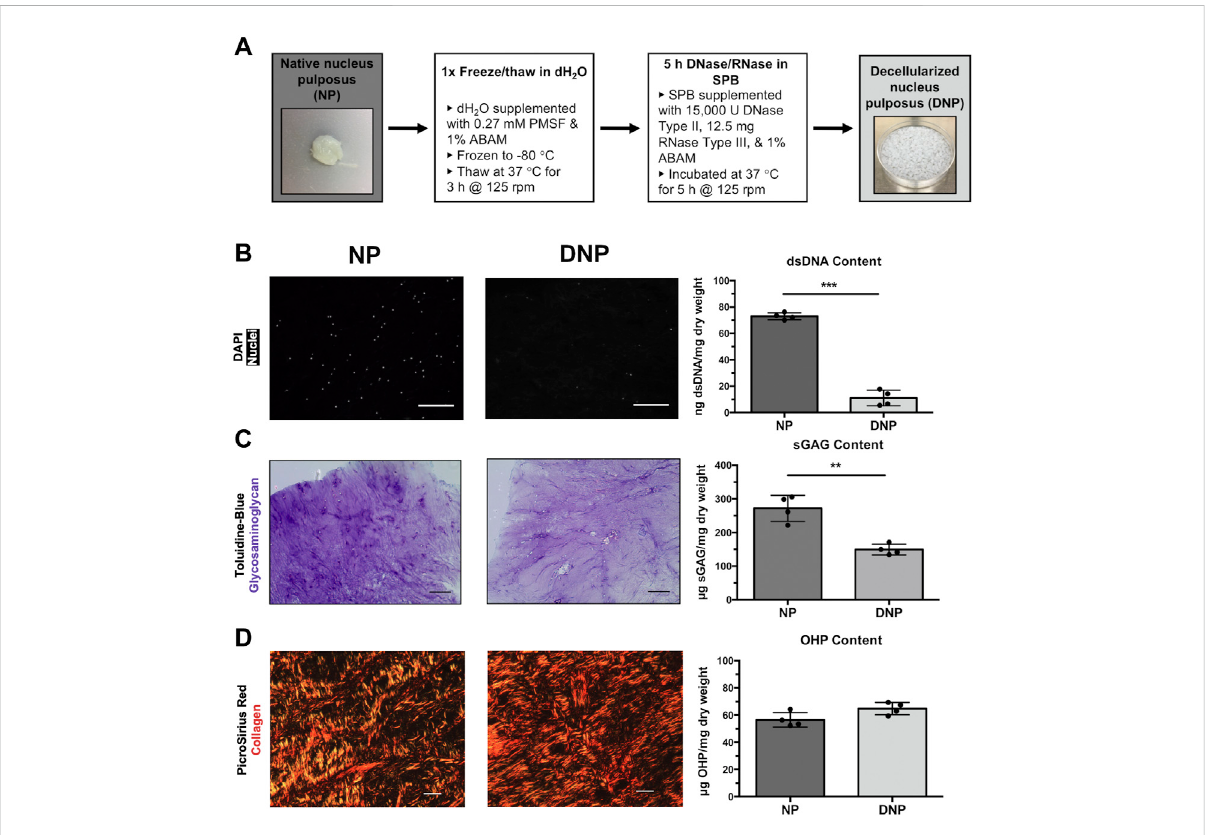
FIGURE 1 Detergent-free NP decellularization protocol effectively extracts cellular content while retaining sulphated glycosaminoglycan (sGAG) and collagen content from native NP. (A) Schematic of detergent-free decellularization protocol. (B) Representative DAPI stained sections of native nucleus pulposus tissue (NP) and decellularized NP (DNP) showed a reduction in cell nuclei (pseudo-coloured in white) following decellularization. Scale bars = 200 μ m. PicoGreen quanti fi cation showed a signi fi cant reduction in dsDNA content in the DNP relative to the native NP. (C) Representative histological sections of NP and DNP stained with Toluidine blue detected GAGs (purple) throughout both DNP and native NP tissue sections, although staining intensity appeared to be reduced within DNP relative to NP. DMMB analysis showed ~45% retention of sGAG content within the DNP relative to the native NP. (D) Representative PicroSirus Red staining of NP and DNP imaged by polarized light microscopy. Staining revealed a complex network of collagen fi bers, with similar patterns detected in the DNP and native NP tissues. Hydroxyproline (OHP) quanti fi cation as a measure of total collagen content showed no signi fi cant difference between DNP and native NP tissues. Scale bars = 200 μ m. Data reported